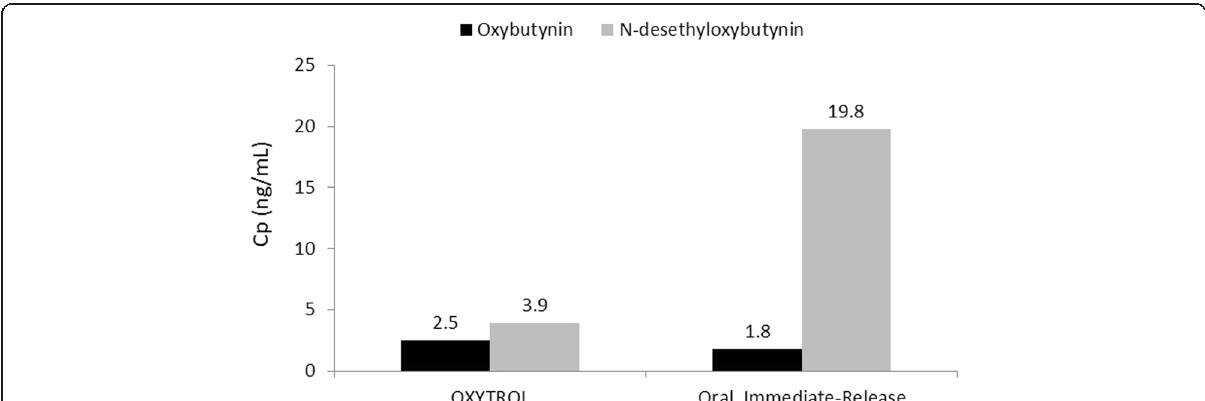
Fig. 15 Comparison of blood levels of oxybutynin and its metabolite, N-desethyloxybutynin, showing that the patch resulted in significantly lower levels of the metabolite, which reduced the dry mouth side effect, compared to the oral immediate release formulation (Oxytrol Package Insert. (available at http://pi.watson.com/data_stream.asp?product_group=1295&p=pi&language=E. Accessed 2 March